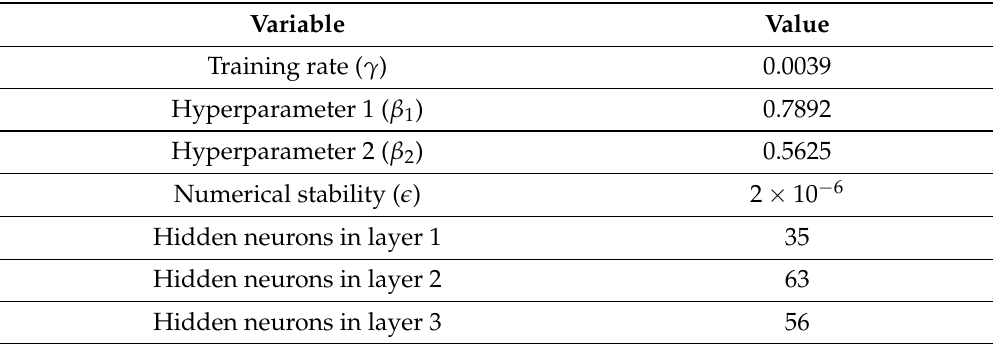
Table 6. Values of selected